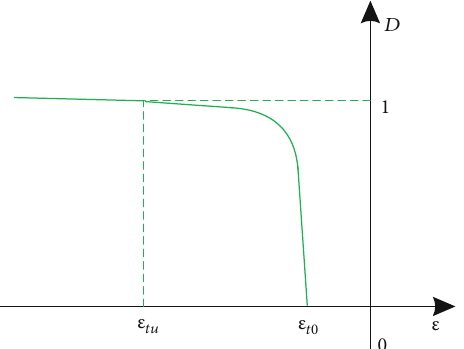
Figure 4: Relationship between damage parameters and e ff ective strain during tensile